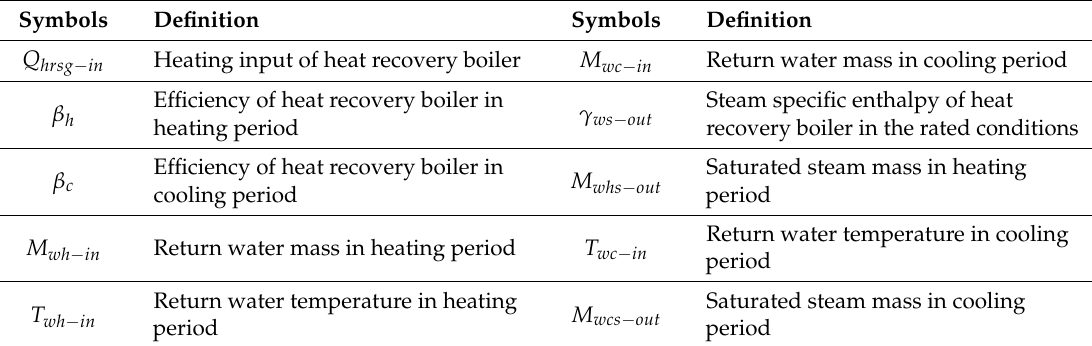
Table 2. Symbols in the equation of the heat recovery boiler.